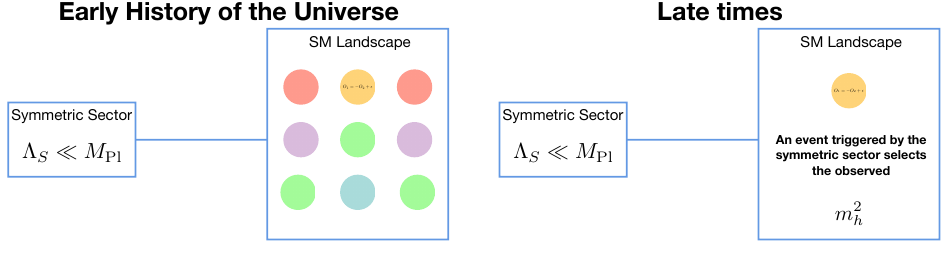
Figure 1 . Models of cosmological selection of the weak scale. A symmetric sector, where a large hierarchy of scales is technically natural, is weakly coupled to a landscape of values of m 2 . The h SM landscape contains tuned values of m 2 including the observed one and is populated early in h the history of the Universe. At a later time a cosmological event selects the observed value of m 2 h through the coupling to the symmetric sector. Different selection mechanisms are shown in figure